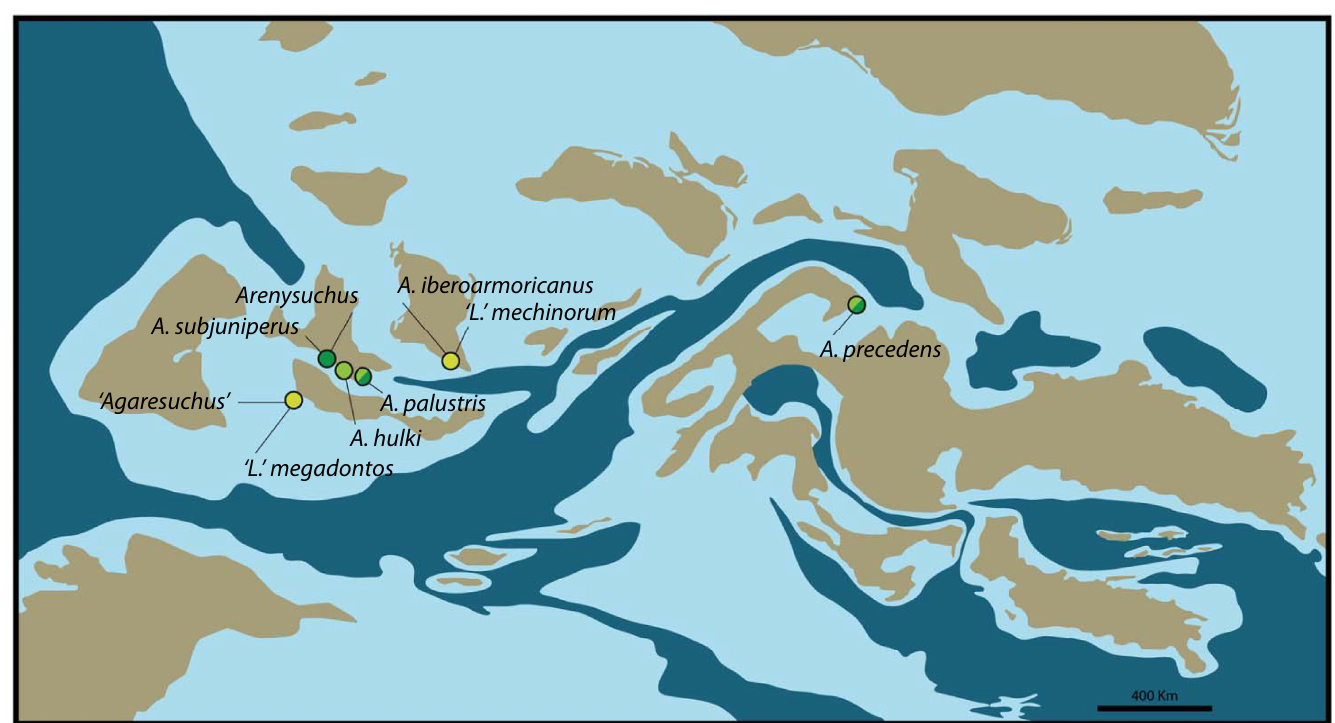
Fig 5. Palaeobiogeographical distribution of Allodaposuchidae. Colours distinguish between late Campanian (yellow), early Maastrichtian (light green) and late Maastrichtian (dark green) taxa. Base map for late Campanian (~ 75 Mya), modified from Csiki-Sava et al. [1] distributed under a CC BY 4.0 license, and based on the reconstruction performed by R.